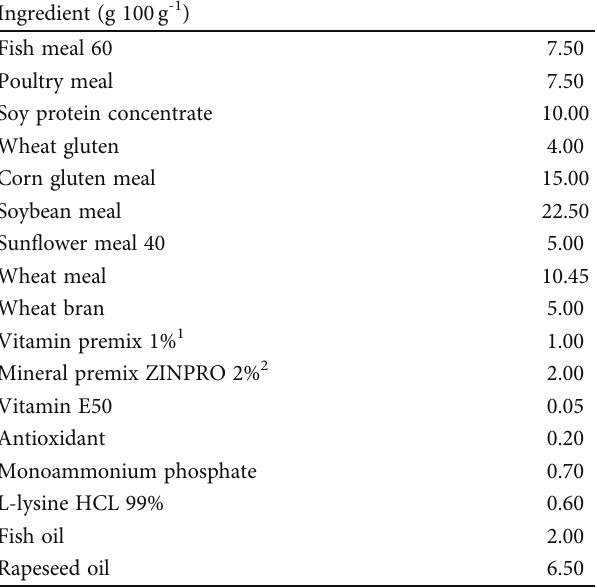
Table 1: Feed ingredients of control